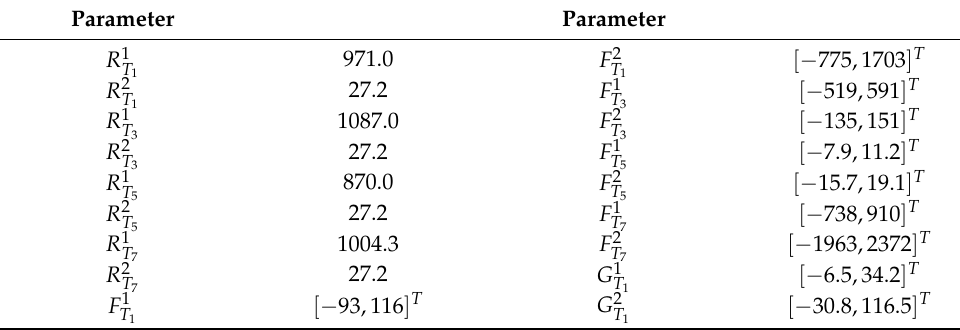
Table 3. Parameters in